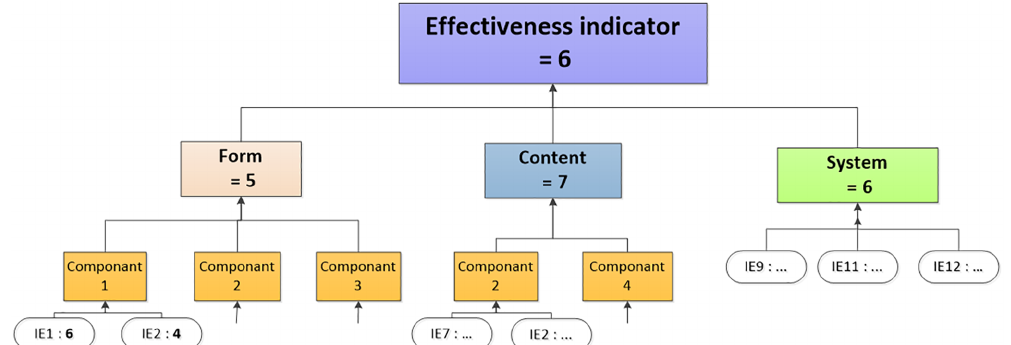
Figure 7. Example of the functioning of the future effectiveness model by indicator